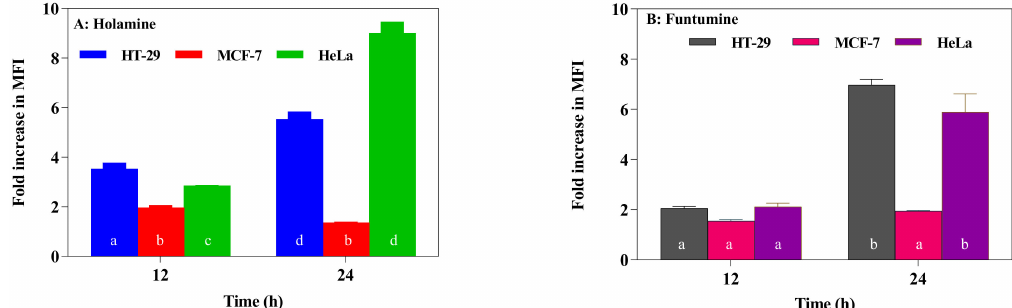
Figure 7. Reactive oxygen species (ROS) in the HT-29, MCF-7, and HeLa cancer cell lines treated with holamine ( A ) and funtumine ( B ). Cells were treated for 12- and 24-h periods with the compounds and thereafter stained with CM-H 2 DCFDA, and the results were evaluated using a flow cytometer. Data are presented as the mean fluorescence intensity (MFI). Each bar represents the mean ± SEM of triplicate experiments. Bars that do not share a common alphabetic character di ff er significantly ( p < 0.05).